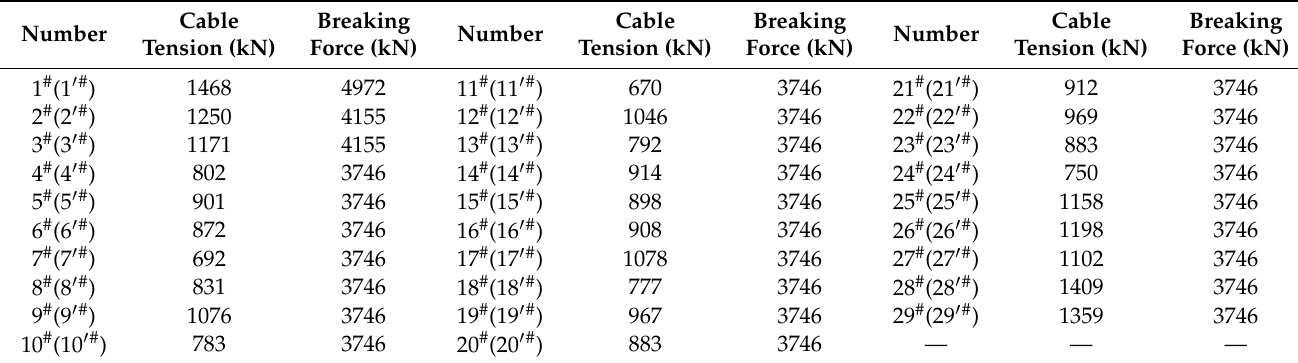
Table 6. Cable force of suspenders in service stage.